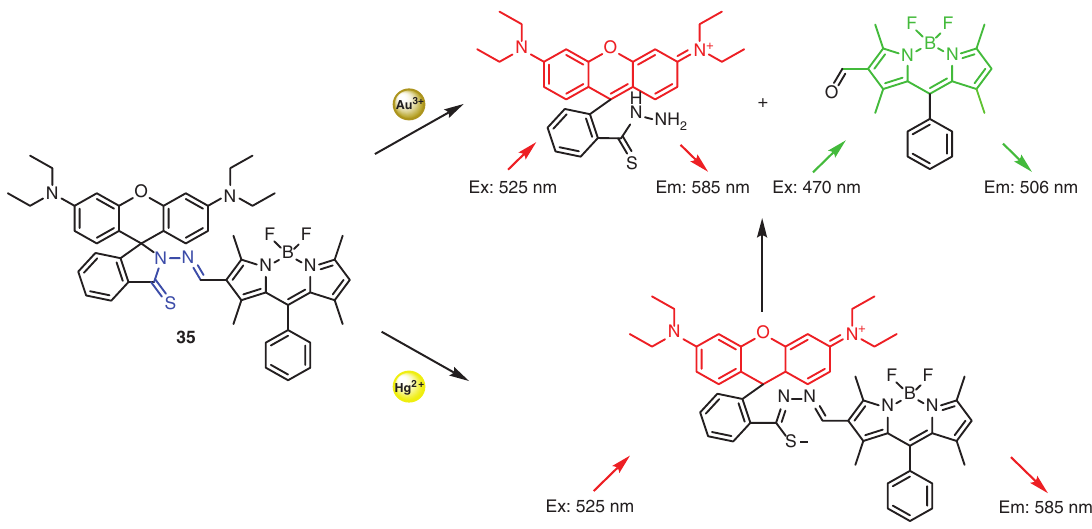
Figure 22: Recognition mechanism of probe 35 with Hg 2 +